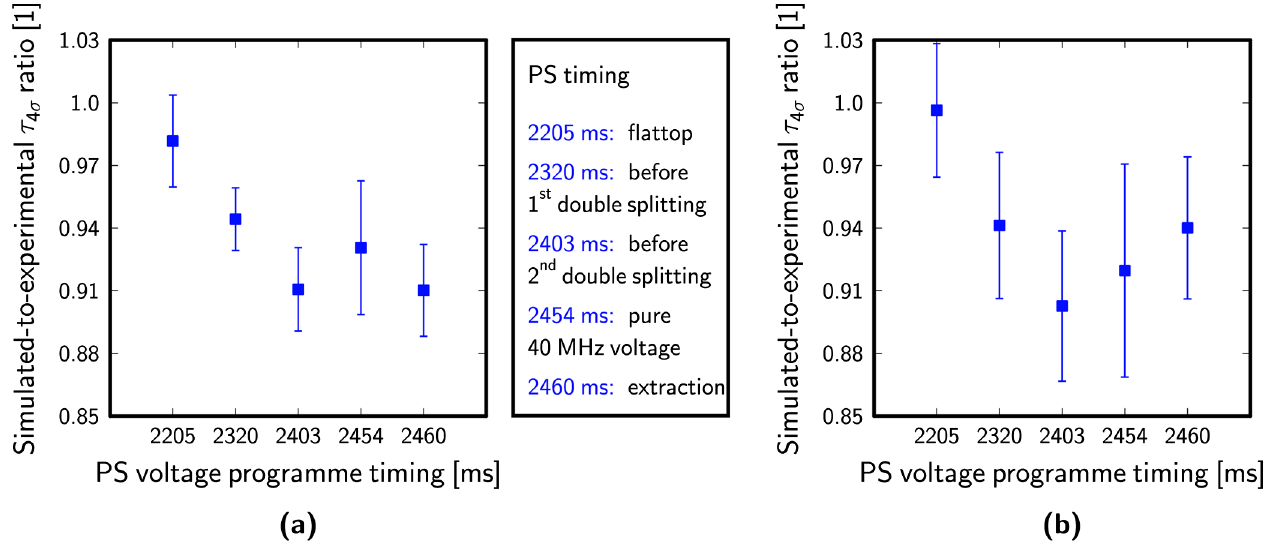
FIG. 3. Simulated-to-measured bunch length ( 4 (cid:1) Gaussian fit) ratio at different moments in the PS. A 25 ns spaced beam under operational conditions at two different intensities (measured at ejection) was investigated. (a) 6 : 4 (cid:1) 10 10 p = bunch . (b) 1 : 3 (cid:1) 10 11 p = bunch .